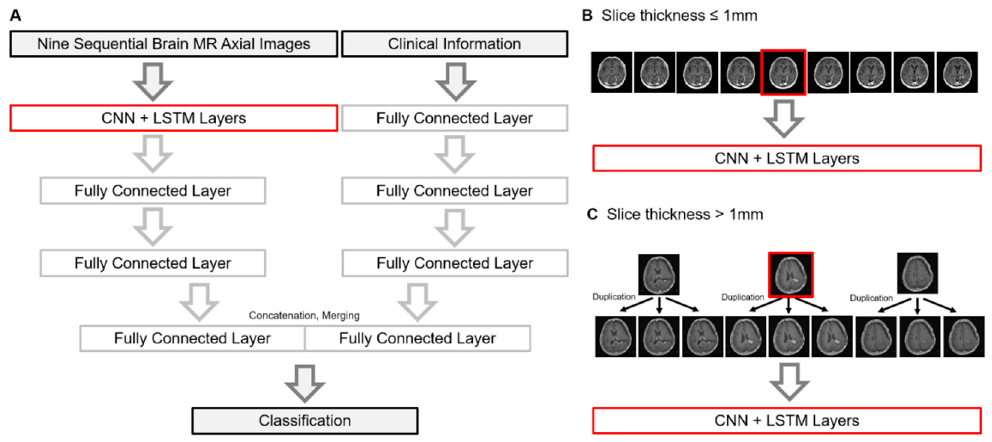
Figure 1. ( A ) Brief schema of the machine learning model. A graphical description how MR images were used when the slice thickness was less than 1 mm ( B ) and thicker than 1 mm ( C ), respectively. Abbreviations: PsPD, pseudoprogression; PD, progressive disease; LSTM, long short-term memory; CNN, convolutional neural network; MR, magnetic resonance.